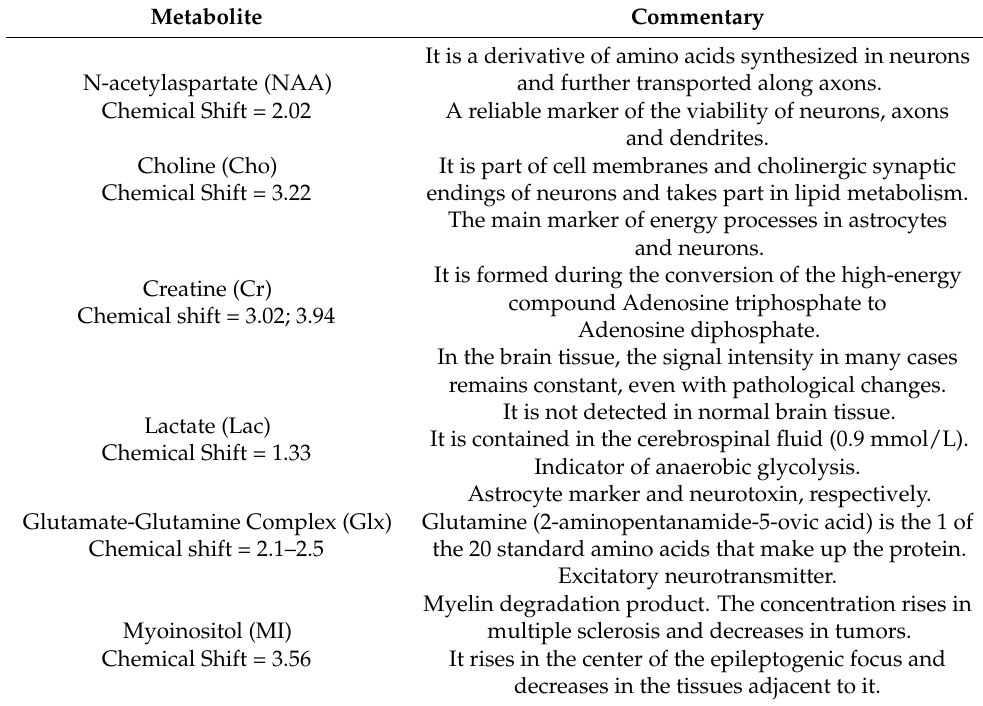
Table 2. Brain metabolites used for magnetic resonance spectroscopy in patients with limbic encephalitis